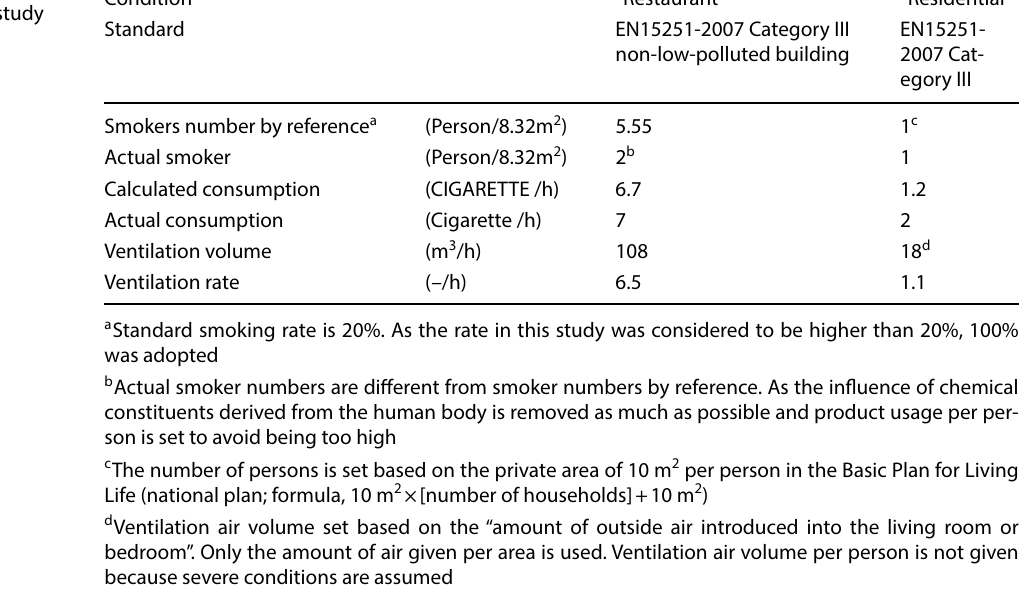
Table 1 Experimental simulations for this IAQ